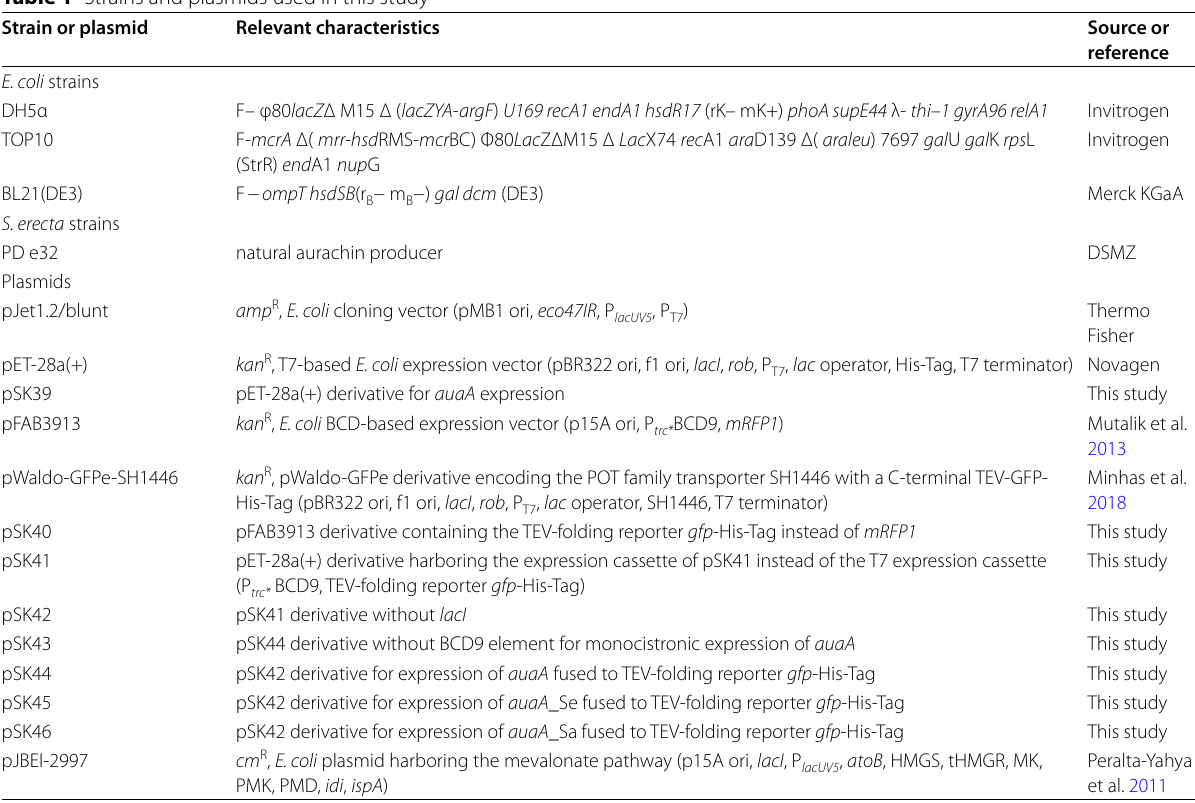
Table 1 Strains and plasmids used in this study Strain or